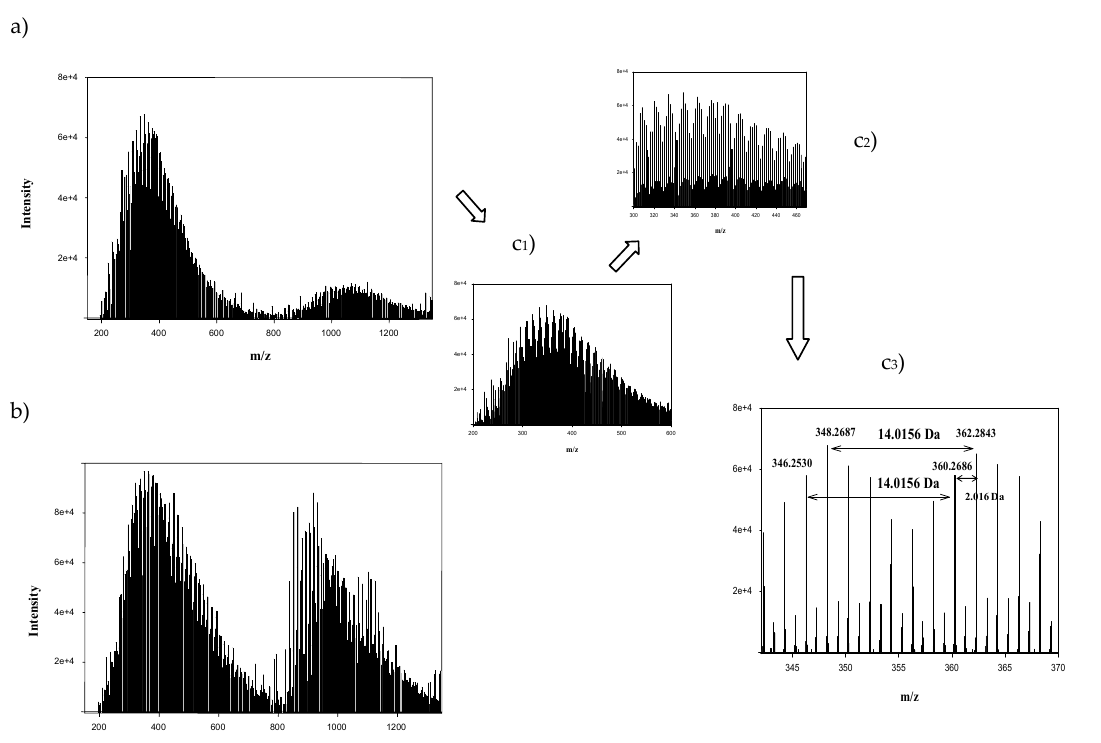
Figure 1. ( a ) FT ICR-MS spectrum of the untreated oil sample; ( b ) FT ICR-MS spectrum of the same sample irradiated by xenon-lamp. The spectrum shows the distribution of multiple ions with a single charge comprised between m/z 150 and 1400; c 1 , c 2 , c 3 insets = mass scale-expanded segments of the full range crude oil mass spectrum in Figure 1a, revealing periodicities of 14.016 Da from compound series differing in the number of CH 2 groups and 2.016 Da from compound series differing in the number of rings plus double bonds.